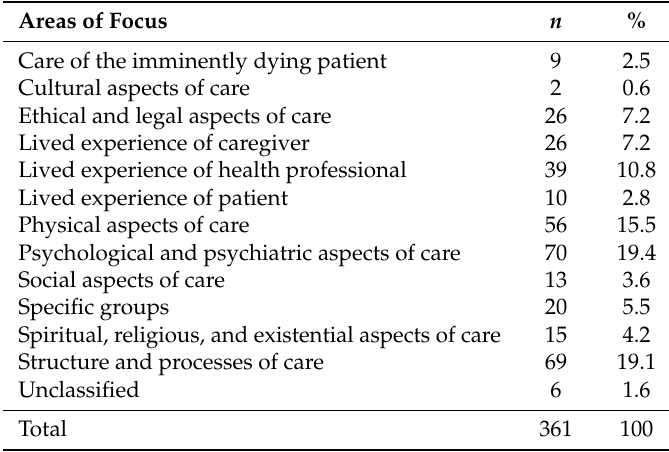
Table 7. Distribution of scientific production by areas of focus ( n and